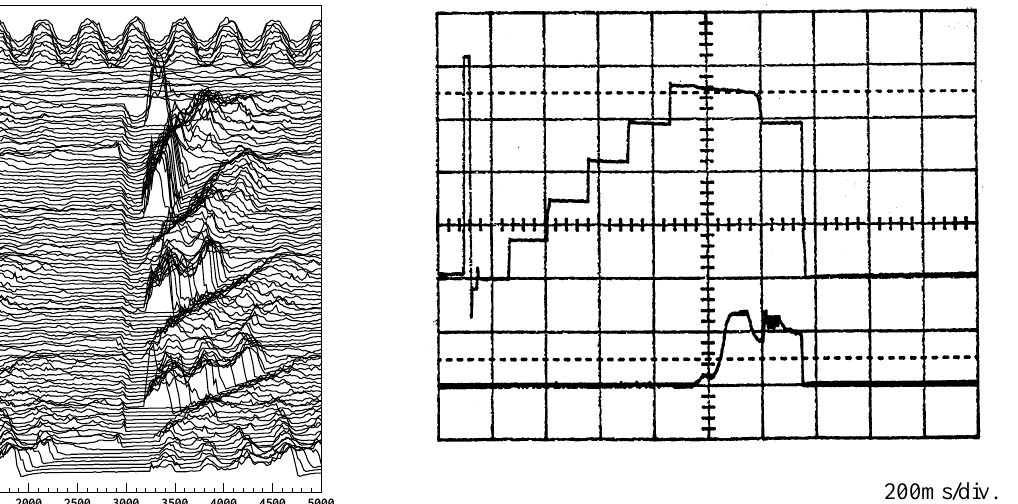
FIG. 11. Slow intensity monitor signal. The horizontal axis is time and its unit is 200 ms (cid:1) division. The upper signal is the slow intensity monitor signal. The lower signal is the envelope of the accelerating voltage. A total of 1.3 3 10 13 protons were